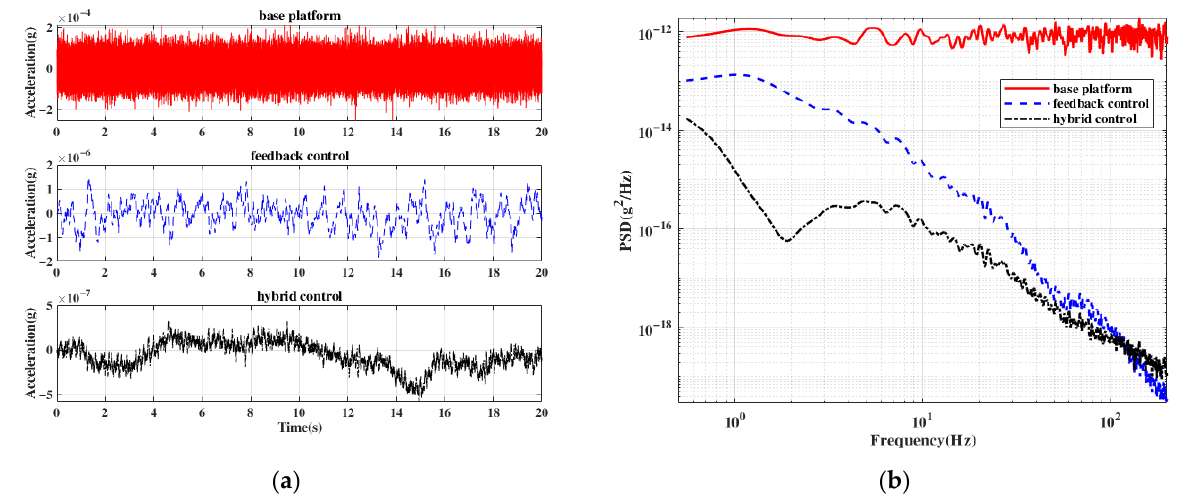
Figure 7. Simulation curves of active control vibration isolation using different control approaches. ( a ) Vibration signal in time domain; ( b ) PSD.